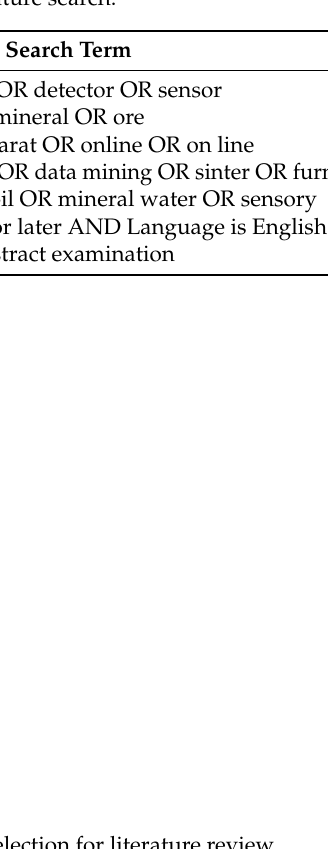
Figure 1. Flow chart of paper selection for literature review.